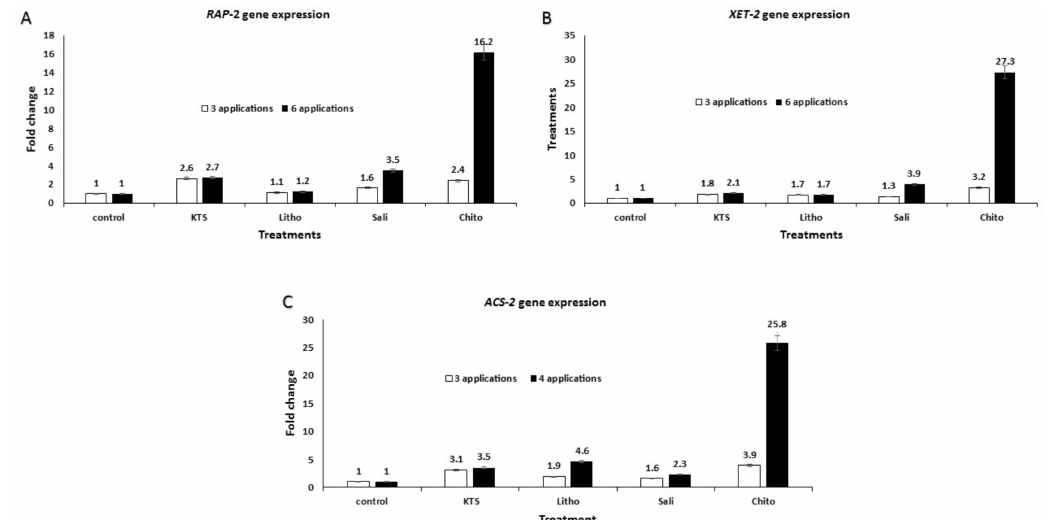
Figure5. Thee ff ectofthetestedchemicalsasapre-harvestfoliarapplicationongeneexpressionprofiling of associated-resistance genes in treated tomato plants using qRT-PCR analysis. ( A ) RAP gene, ( B ) XET–2 gene, and ( C ) the ACS–2 gene fold change after three- and six-spray applications with K-thiosulfate (KTS) / 4 g L − 1 , lithovit (Litho) / 4 g L − 1 , salicylic acid (Sali) / 1.5 g L − 1 and chitosan (Chito) / 4 g L − 1 , respectively. The Actin gene was used as an internal reference gene for data normalization